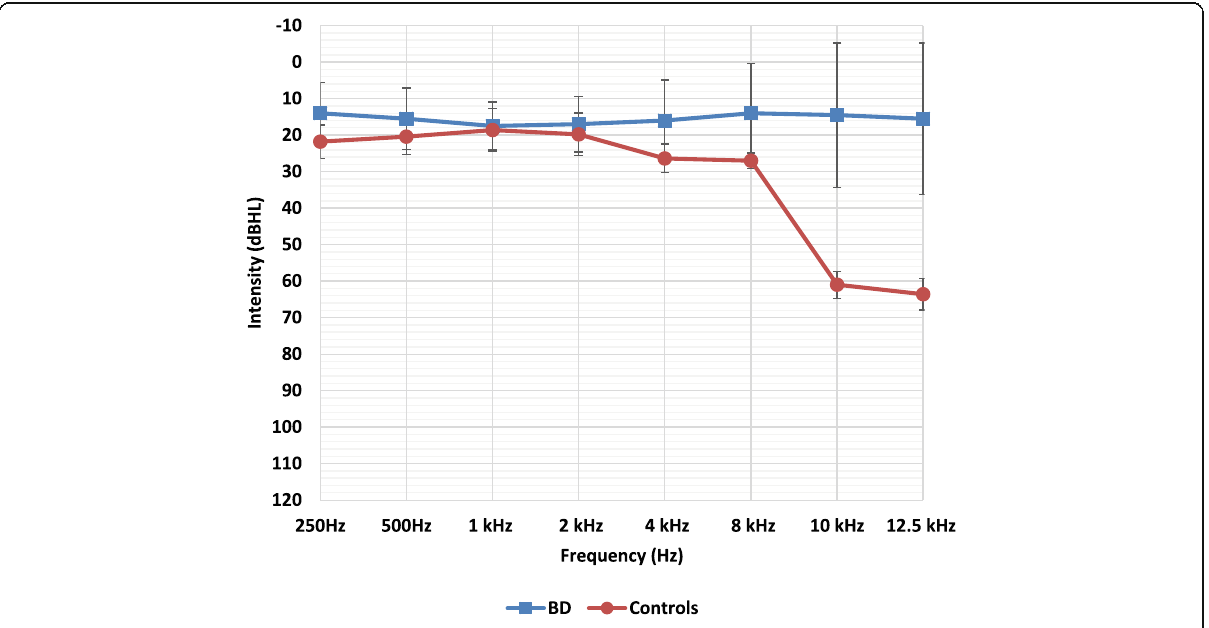
Fig. 2 PTA of BD patients and controls in the LT